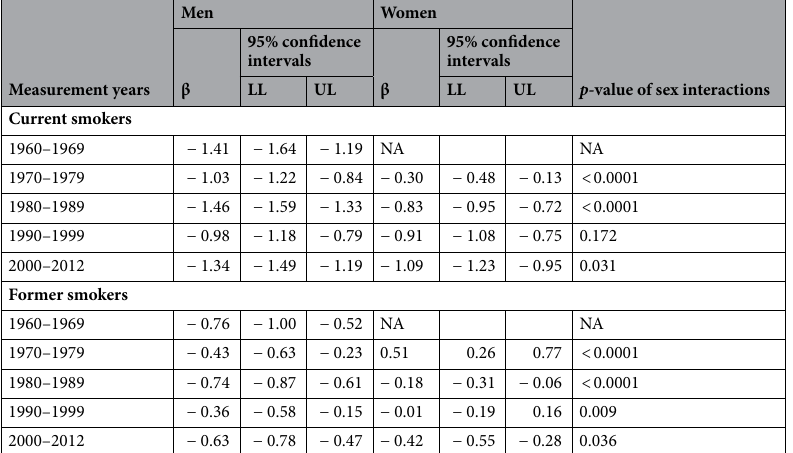
Table 2. Educational years of current smokers and former smokers as compared to never smokers by sex and measurement year. Adjusted for age, birth cohort and twin cohort.